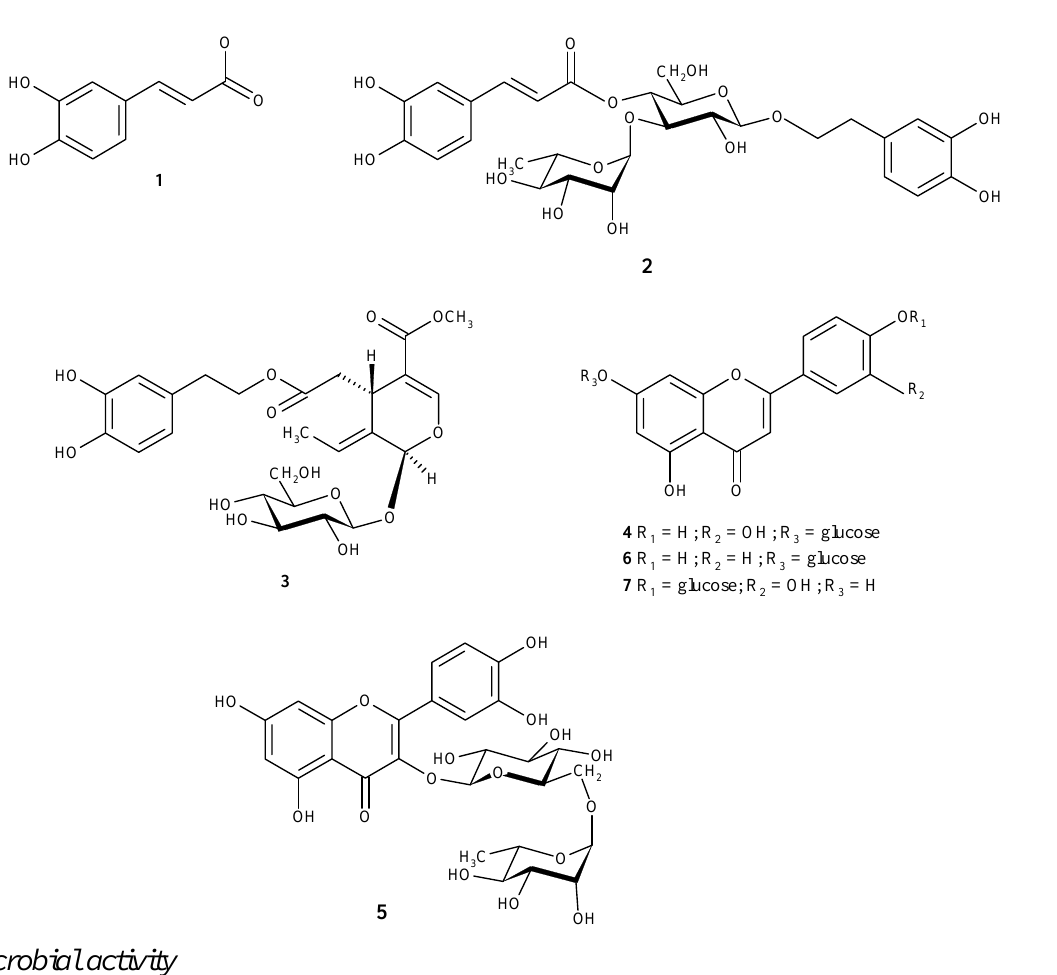
Figure 2. Chemical structures of identified phenolic compounds. (1) caffeic acid; (2) verbascoside; (3) oleuropein; (4) luteolin 7- O -glucoside; (5) rutin; (6) apigenin 7- O - glucoside; (7) luteolin 4’- O